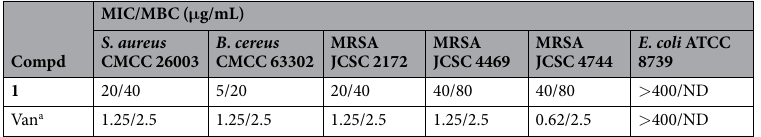
Table 2. In vitro antibacterial activities of callistemenonone A ( 1 ) against bacteria strains. a Positive control; Van = vancomycin; ND: not